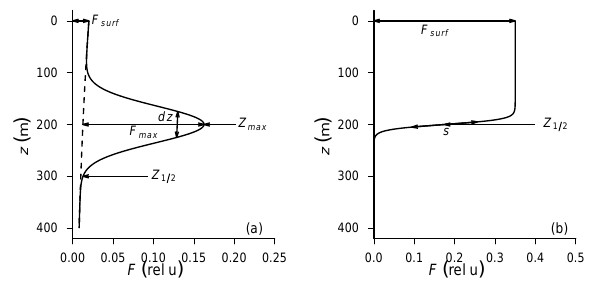
Fig. 2. Schematic representation of the vertical distribution of flu- orescence with depth. (a) Case of non-uniform profile. The typical shape is modeled by a gaussian distribution (plain line) superim- posed onto an exponential decrease (dashed line). The exponen- tial decrease is defined by one concentration-dependent shape pa- rameter F surf (relative units) and one depth-dependent shape pa- rameter Z 1 / 2 (m). The gaussian distribution is defined by one concentration-dependent shape parameter F max and two depth- dependent shape parameters Z max (m) and dz (m). (b) Case of uniform profile. The typical shape is modeled by a sigmoid curve (plain line), defined by one concentration-dependent shape parame- ter F surf (relative units) and two depth-dependent shape parameters Z 1 / 2 (m) and s (m − 1 ) . See Table 1 for